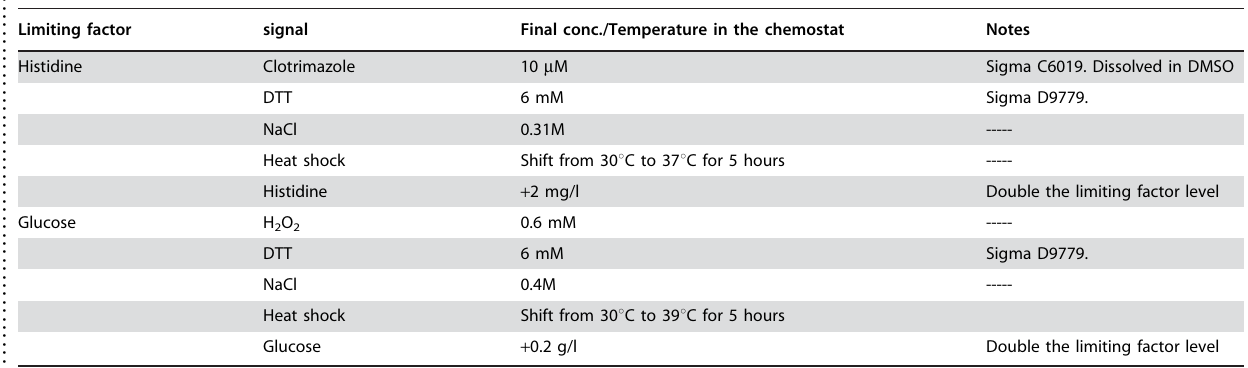
Table 1. Environmental cues imposed on steady state growing yeast cells. .. ... .... ... ... .... ... ... .... ... ... .... ... ... .... ... ... .... ... ... .... ... ... .... ... ... .... ... ... .... ... ... .... ... ... .... ... ... .... ... ... .... ... ...